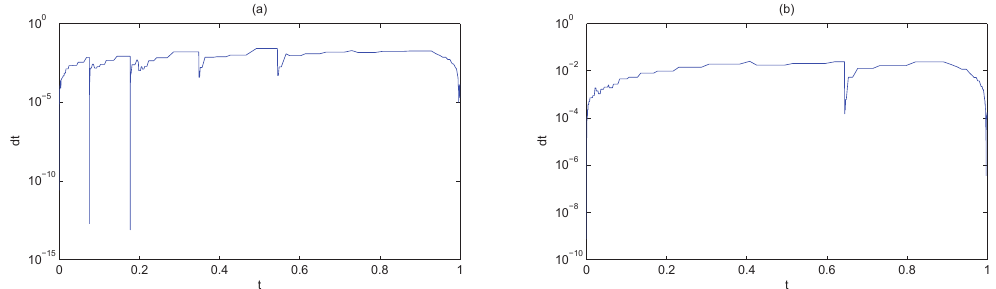
Figure 2. The time step size for the Advection-diffusion equation with Huang’s method ( a ) and the proposed method ( b ), N = 21.